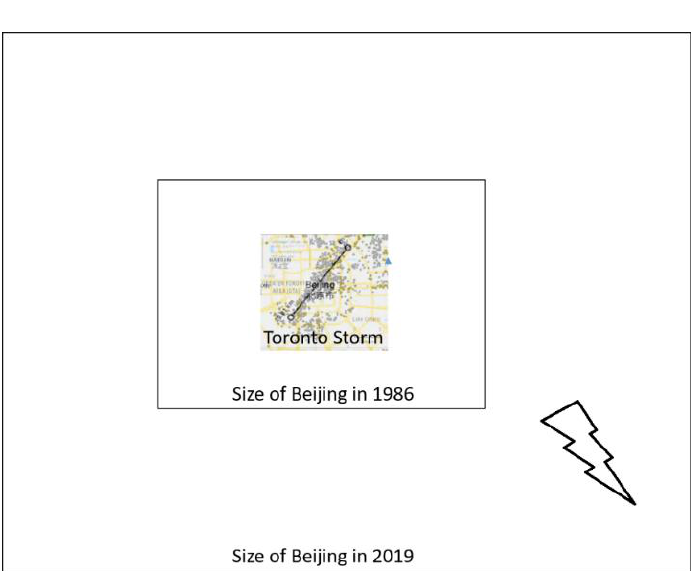
Figure 5. Annual number of rainy days in Beijing (1951–2016) GHCND: CHM00054511 [36]. Increasing urban spatial dimensions and the number of storms is forcing consideration of urban drainage systems to transition to the future. City engineers have to expand the spectrum from “too little water” (shortage of water supply) to “too much water” (flooding). When adding in the complications associated with megacities as a result of both their enormous water demands and the anthropogenic water quality